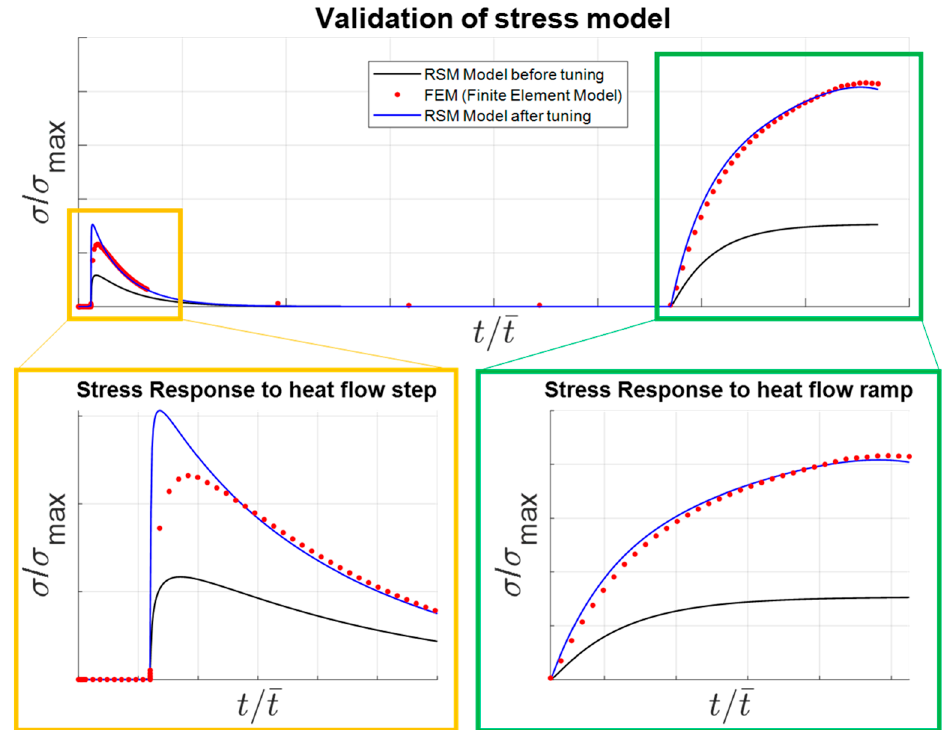
Figure 3. Testing of the tuning procedure to step and ramp increase of heat flow for the rotor stress monitoring, highlighting the stress trends before and after the tuning with respect to the FEM Simulation © 2020 Baker Hughes Company—All rights reserved.